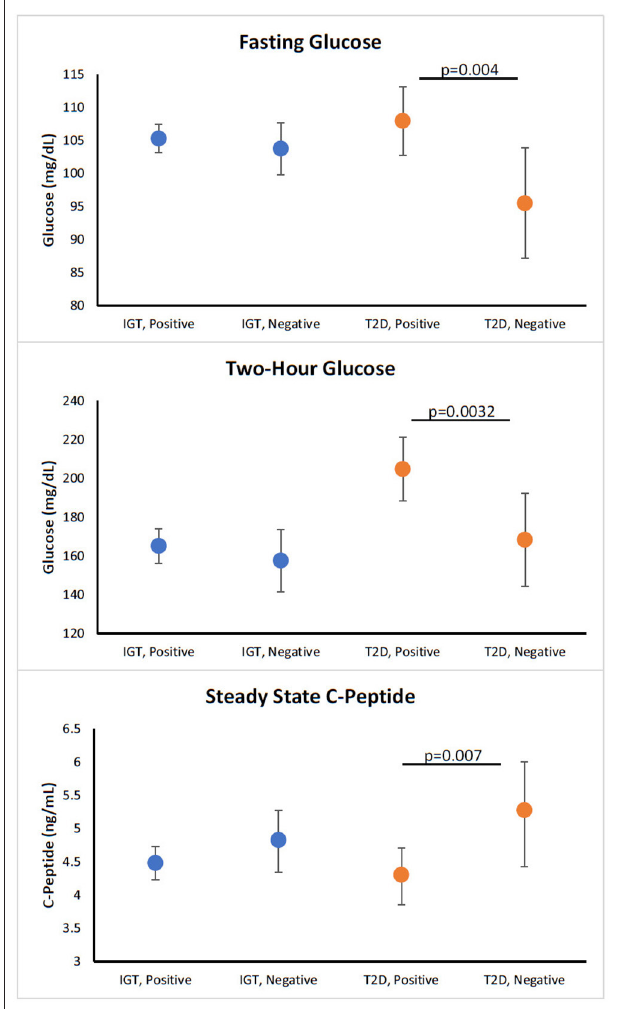
FIGURE 1 | Relationship of T cell positivity with month-12 β -cell function in participants with new T2D and participants with IGT. Figures show adjusted means for values at month 12 visits. All models are adjusted for age, sex, race/ethnicity, treatment group, and baseline value of dependent variable. All models except for BMI are also adjusted for baseline BMI. Models for SSCP, and ACRPg are also adjusted for baseline and month-12 insulin sensitivity (M/I). Orange symbols represent participants with new T2D and blue symbols represent participants with IGT. P -value for comparison between autoimmune negative and positive for diabetes or